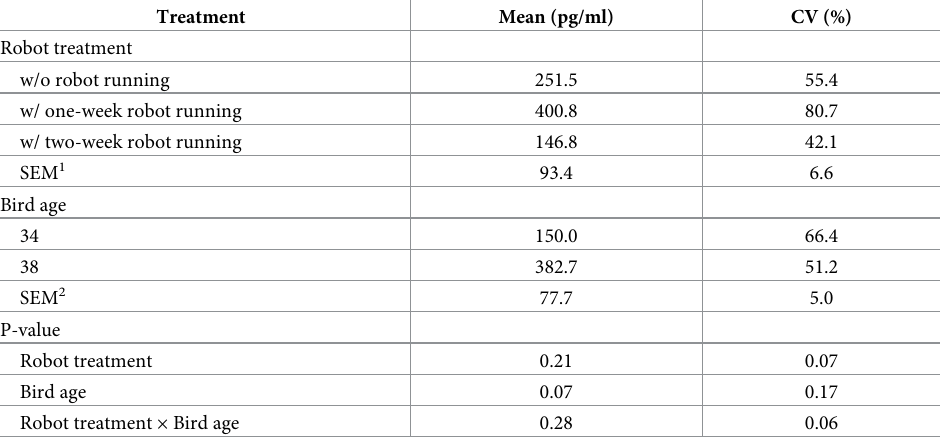
Note: 1 Standard errors are for the effect of robot treatment (n = 8) and 2 Standard errors are for the effect of bird age (n = 12). ‘w/’ and ‘w/o’ represent with and without, respectively.